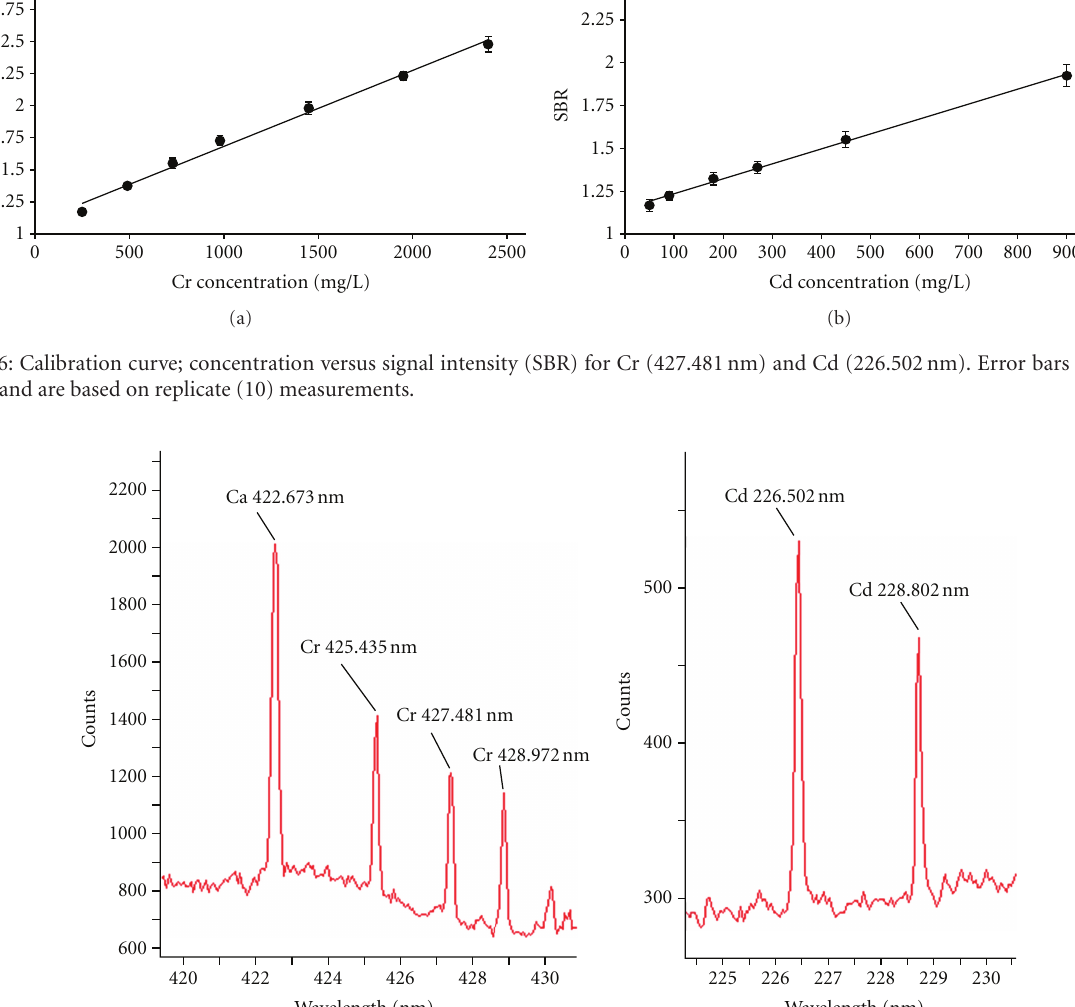
obtained. All calibration curves demonstrated good linearity with correlation coe ffi cients, R 2 of 0.992 for chromium and 0.998 for cadmium,